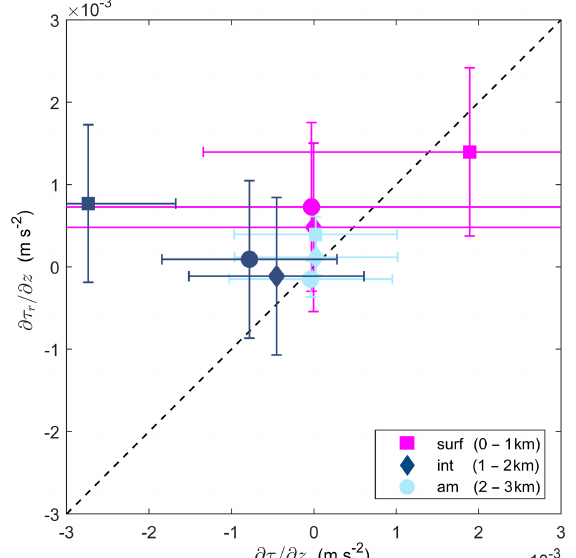
Figure 12. Spectral analysis of temperature in the interface (3.5m) for the entire mooring time series, split into half-overlapping inter- vals equivalent to the inertial frequency (20 ◦ of freedom), and the spectrum was computed using Welch’s periodogram method. The focus is on the [ f,N ] range with particular frequencies highlighted. For reference, spectral slopes of − 2 and − 5 / 3 are indicated by the black dashed lines, and a 95% confidence interval is the shaded region around the